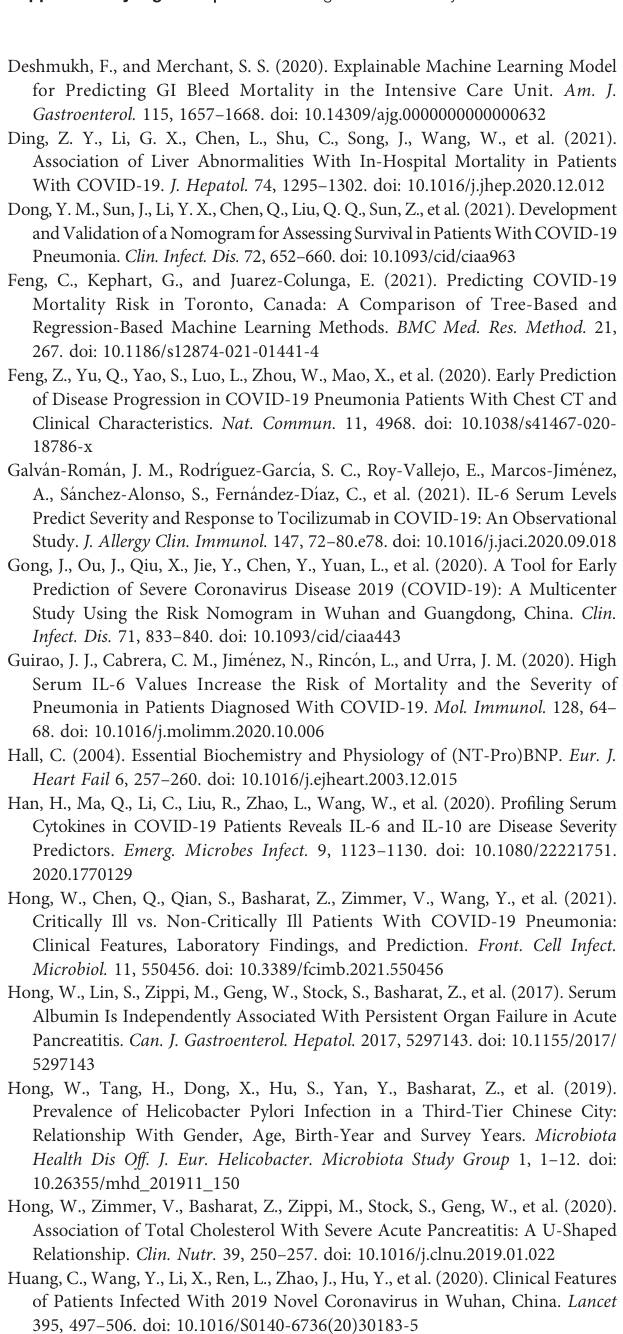
Supplementary Figure 1 | Data fl ow diagram of this